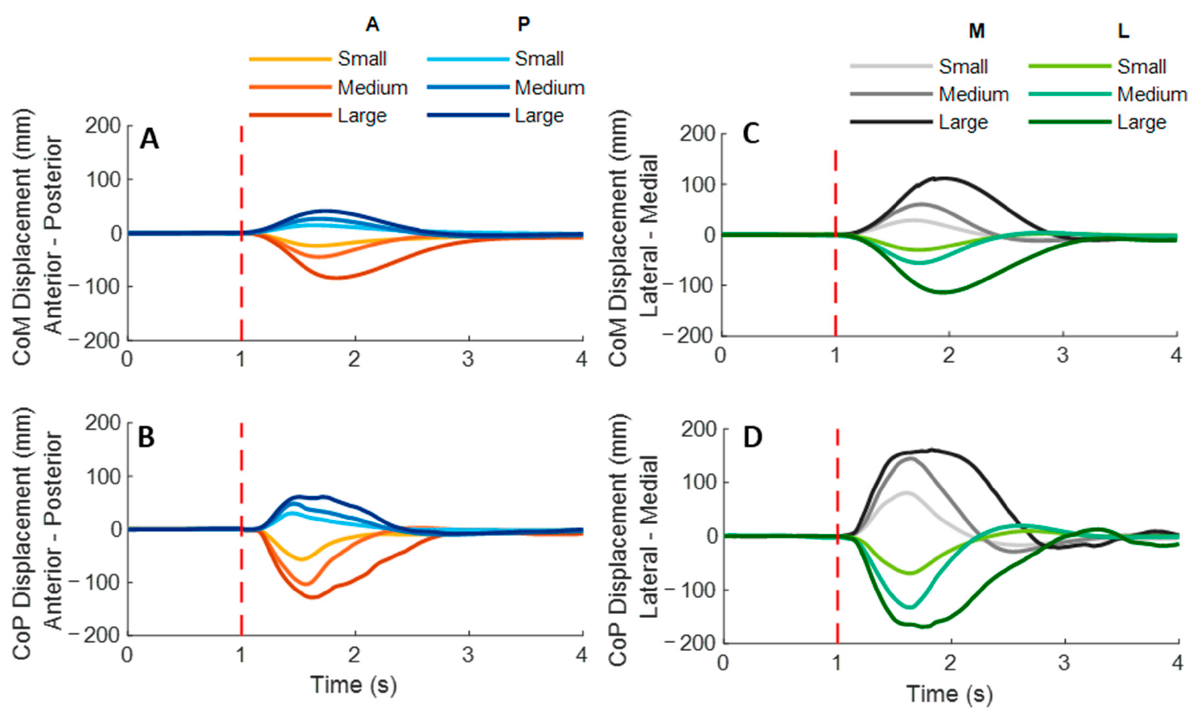
Figure 3. The mean whole-body CoM and CoP displacements of twelve participants following the unexpected anterior, posterior, medial, and lateral perturbations with three magnitudes ( n = 12). Mean CoM ( A ) and CoP ( B ) displacements following anterior and posterior perturbations; Mean CoM ( C ) and CoP ( D ) displacements following medial and lateral perturbations. (Note: The red dotted line indicated the start of pulling perturbation. CoM : center of mass; CoP : center of pressure. A : anterior; P : posterior; M : medial; L : lateral).